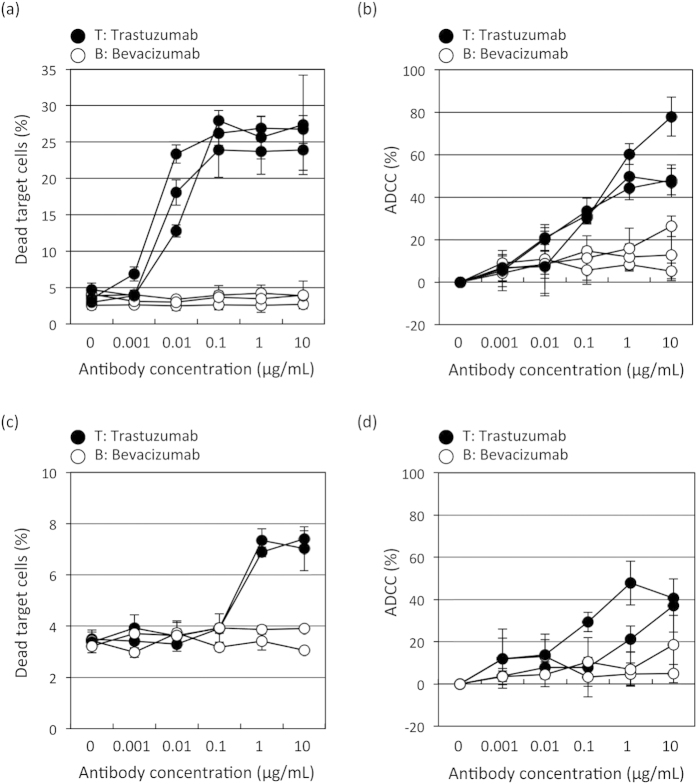
Comparison of the new flowcytometric and calcein-release assay.The flowcytometric (a,c) and calcein-release (b,d) assays were performed on different days, independently, to assess their reliability and reproducibility for evaluating ADCC, using NK92MI + CD16a (a,b) or PBMCs freshly isolated from the same healthy donor on different days (c,d). The results of the analyses of dead target cells (%) and ADCC (%) are presented as mean values ± SD for each of the experiments.